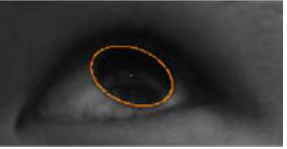
Figure 12: An Example of ellipse fitting for iris